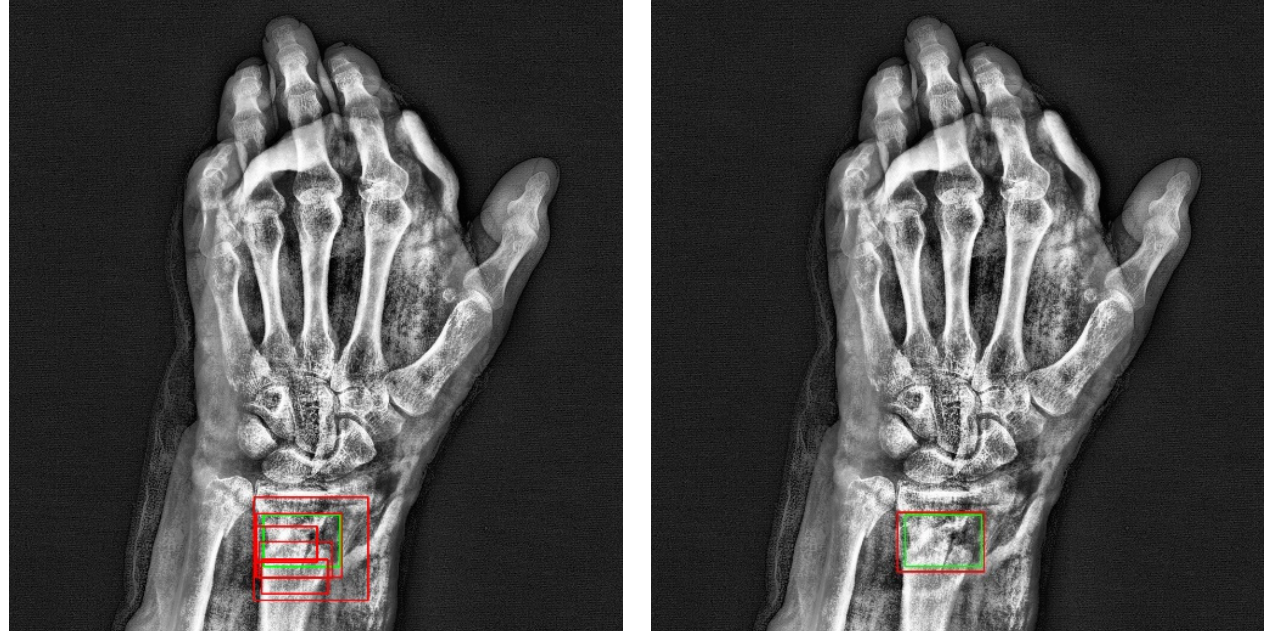
Figure 21. Sample of left wrist fracture results [ground-truth bounding box (green), predicted bounding box (red)].